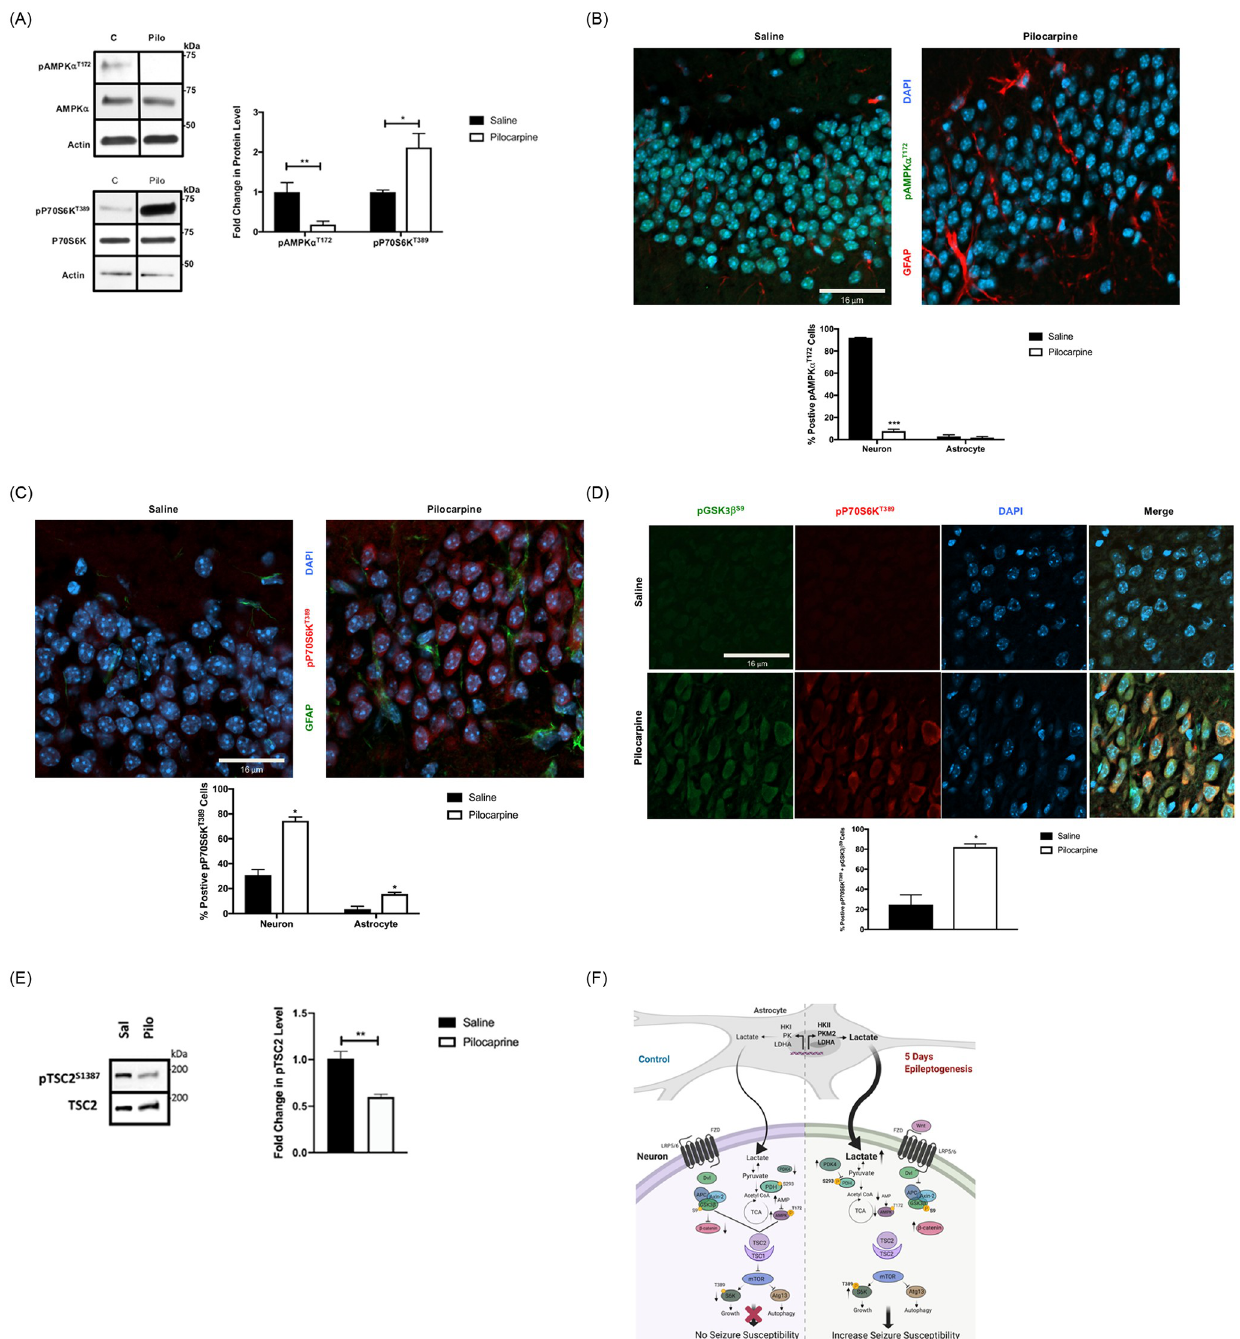
Fig 5. Induced Wnt signaling post-SE coordinates AMPK and mTOR signaling pathways. (A) Coordinated inhibition of AMPK and activation of P70S6 Kinase. (Left) Representative western blots with quantification (Right) comparing the expression of pAMPK α T172 and pP70S6K T389 in hippocampi at day 5 following SE with pilocarpine (Pilo) or control (saline). (n = 3–4 mice/group). Data are represented as mean ± SEM. � P < 0.05, �� P < 0.01 by unpaired student’s t -test using Prism 9.0 (Graphpad). (B and C) Localization of AMPK and mTOR activation by confocal microscopy. Representative confocal sections with quantified analysis of positive pAMPK α T172 (green; B) and pP70S6K T389 (red; C) neuronal cells (see supplemental methods) are increased in the DG region of 5-day post-pilocarpine induced-SE when compared to control saline. [GFAP (red in B; green in C) and Dapi (blue)]. Data are represented as mean ± SEM. � P < 0.05, ��� P < 0.001 by unpaired student’s t -test using Prism 9.0 (Graphpad). (D) pP70S6K T389 and pGSK3 β S9 co-localize to neurons. Immunostaining with pP70S6K T389 (red) and pGSK3 β S9 (green) show both co-localize to neuronal cells and are higher in percentage (see supplemental methods) at day 5 post-SE with pilocarpine when compared to control. [Dapi (blue)]. (E) TSC2 phosphorylation inhibited at day 5 post-SE. Representative